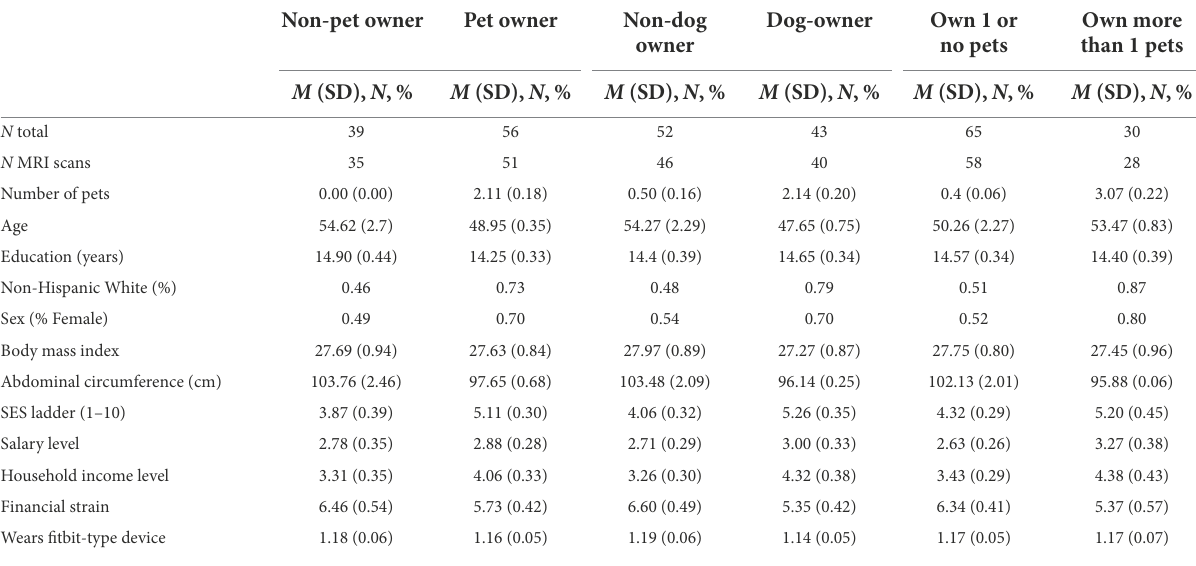
TABLE 2 Sociodemographic